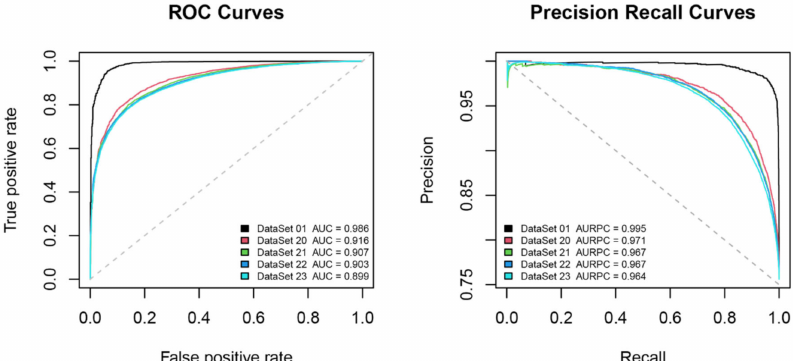
Figure 13. Recall-precision and ROC curves displaying the performance of LightGBM on testing datasets of DataSet 01, DataSet 20, DataSet 21, DataSet 22 and DataSet 23. Note that the scale of values on the vertical axis is di ff erent from recall-precision curves (0.75–1.) and ROC curves